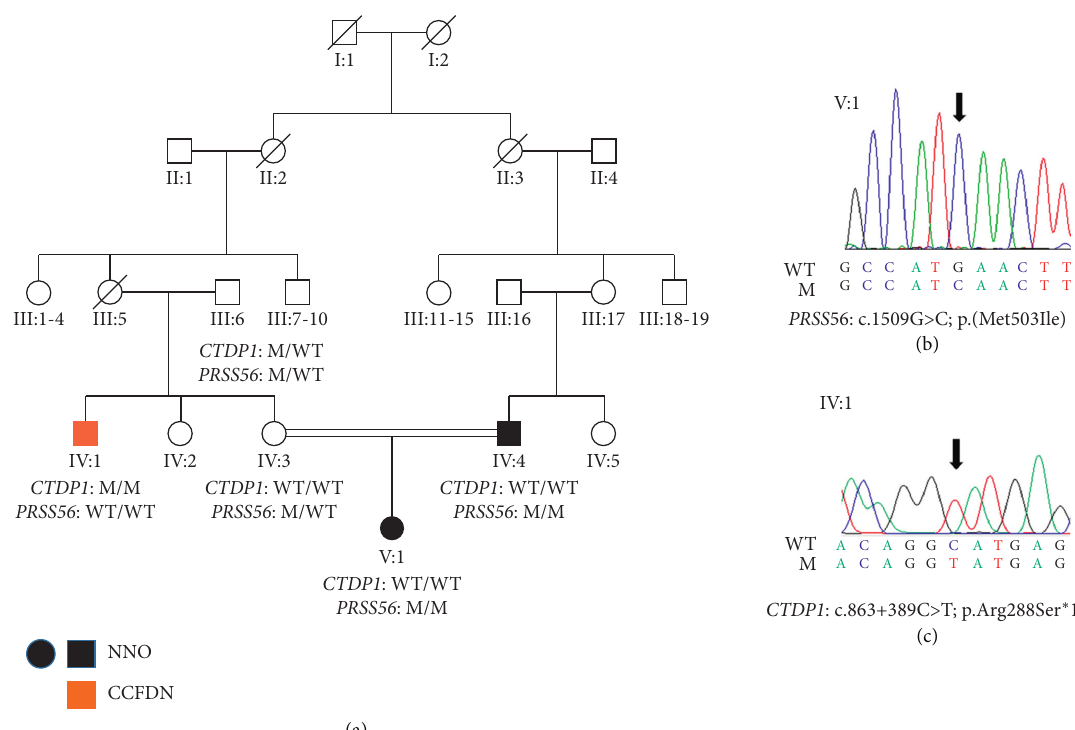
Figure 1: Segregation of the identified mutations. (a) Pedigree of the family, (b) sequence chromatogram of the homozygous variant c.1509G > C in PRSS56 (NM_001195129.2), and (c) sequence chromatogram of the homozygous variant c.863+389C > T in CTDP1 (NM_004715.4). CCFDN, congenital cataracts, facial dysmorphism, and neuropathy syndrome; M, mutation; NNO, nanophthalmos; WT, wild